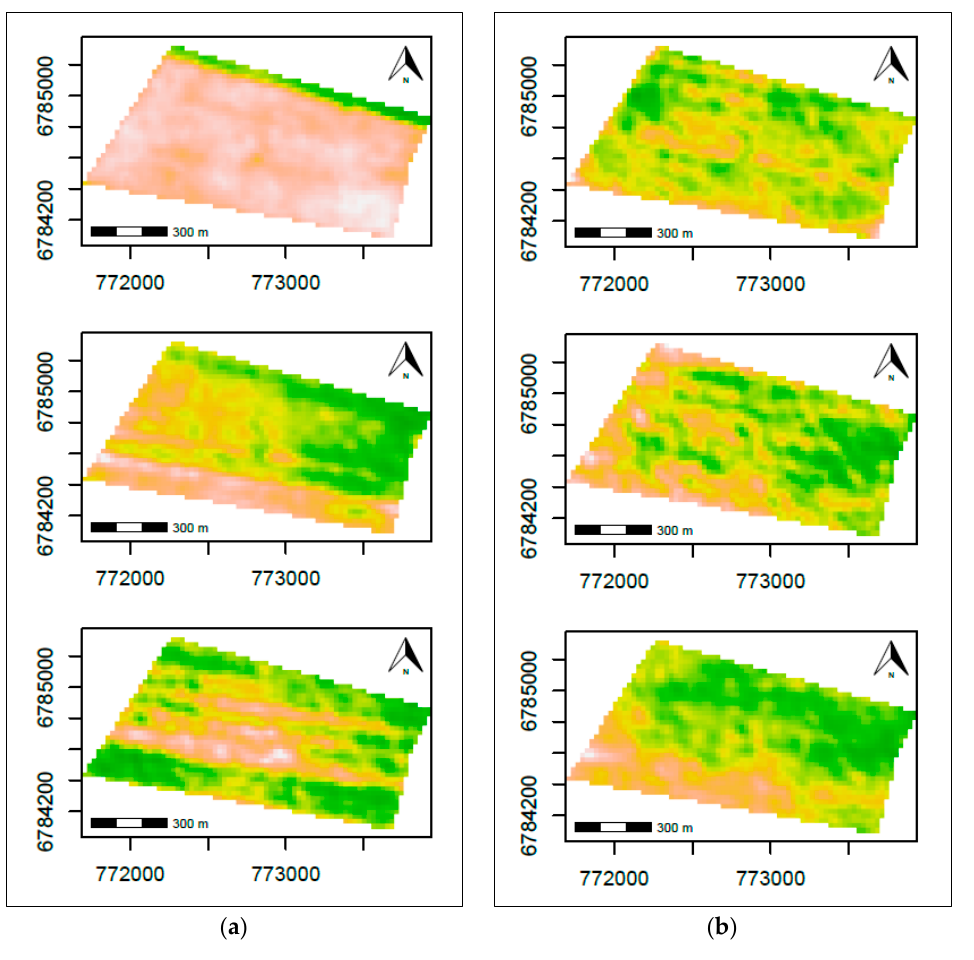
Figure 4. The average EVI from six years for Field 4 to illustrate ( a ) years where split management was identified based on the imagery and ( b ) where no such split management was identified.